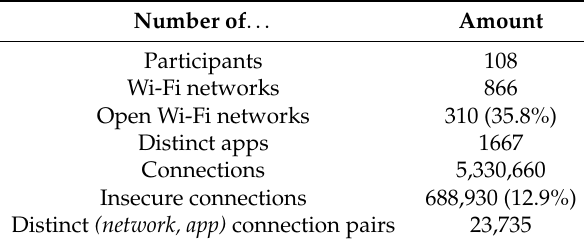
Table 2. Statistics for the collected data.